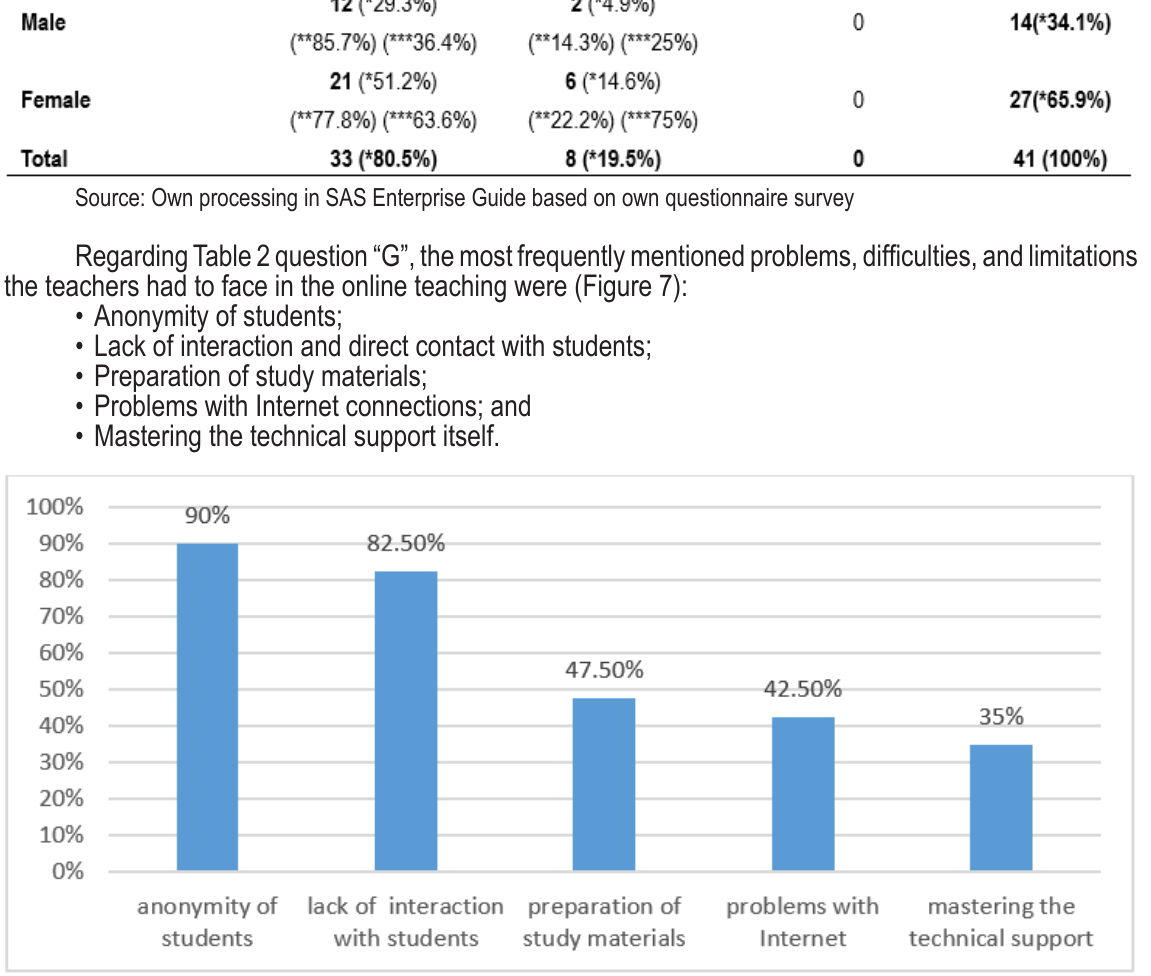
Figure 7. Limitations of the online form of education from the teachers’